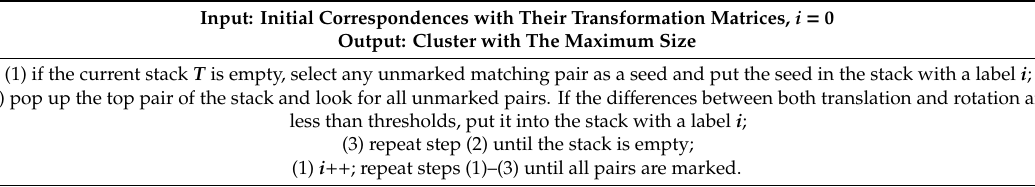
Table A2. Algorithm 2 Maximum Sample Set Chosen by Clustering.